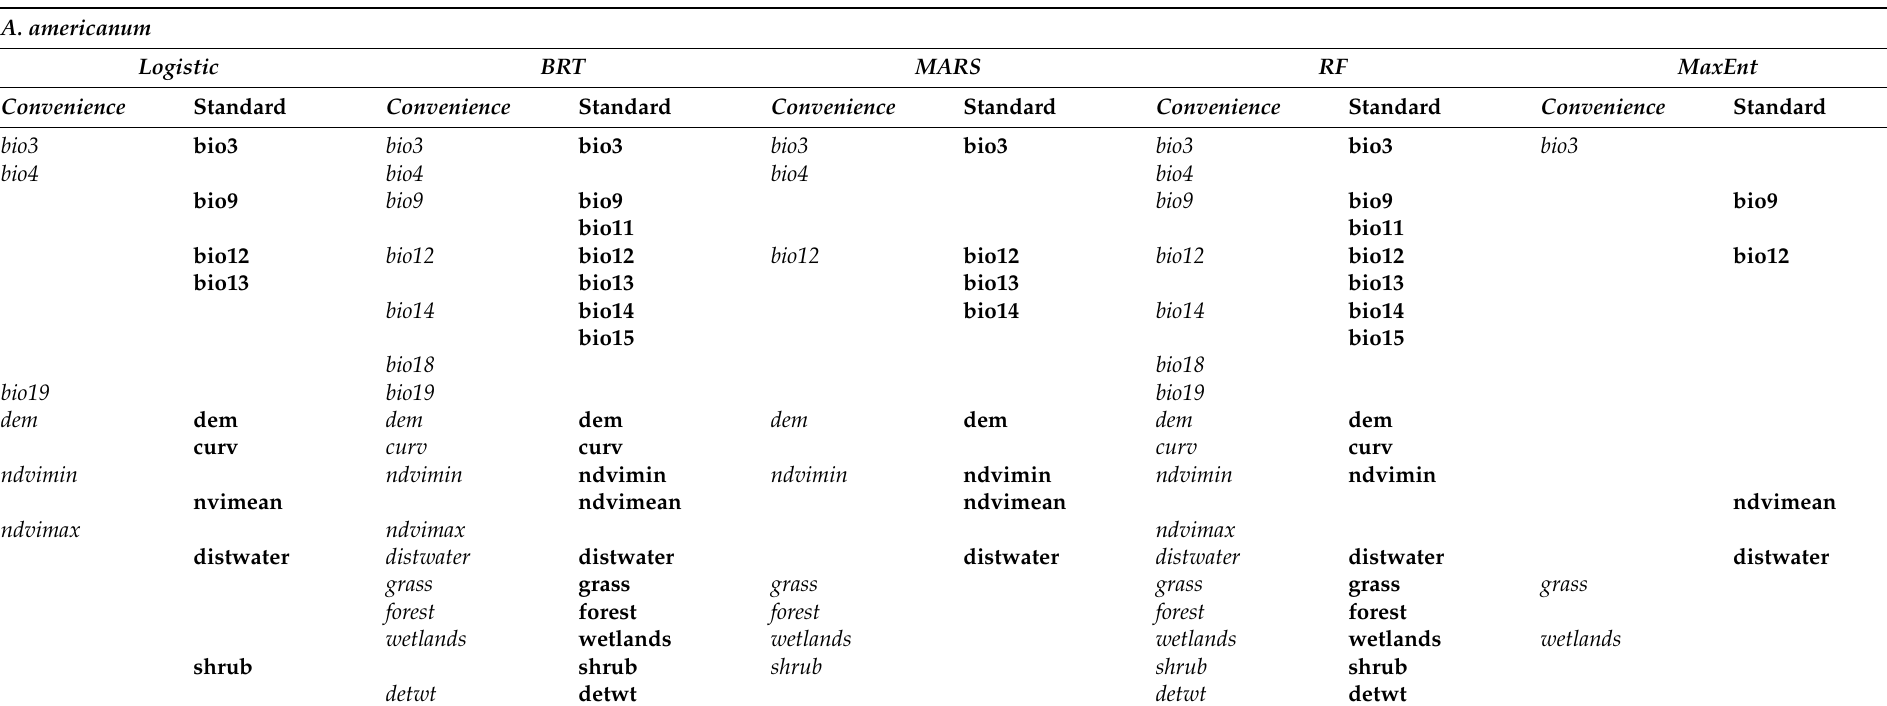
Table 1. Environmental variables selected for SDMs (Logistic, BRT MARS, RF, and MAXENT) for Convenience Sampling (Convenience; variables in italics)